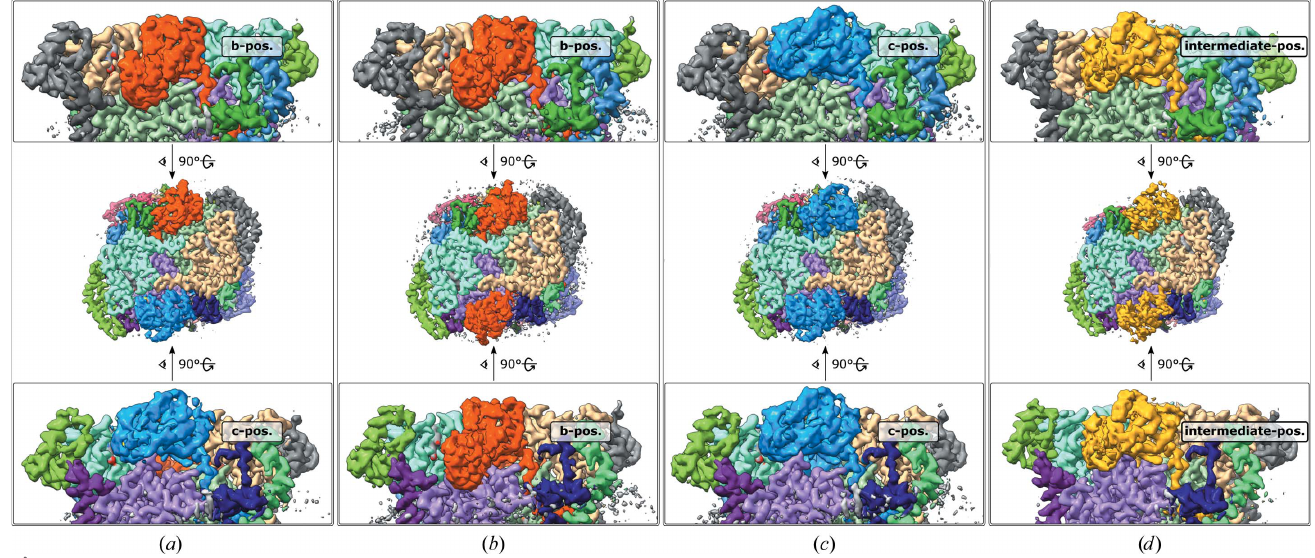
Figure 6 Typical maps from the +FCN sample with both Rieske domains in the CIII dimer. Rieske domains are coloured red, yellow and blue for the b , intermediate and c positions. ( a ) Refinement of particle pairs with one protomer in the b position and one in the c position (30 714 particles, 2.7 A˚ resolution, C 1). ( b , c , d ) Maps from the refinement of particle pairs with both protomers in the b position (6727 particles, 3.0 A˚ resolution, C 2), c position (11 987 particles, 2.8 A˚ resolution, C 2) and intermediate position (9819 particles, 2.8 A˚ resolution, C 2). All possible permutations of positions were